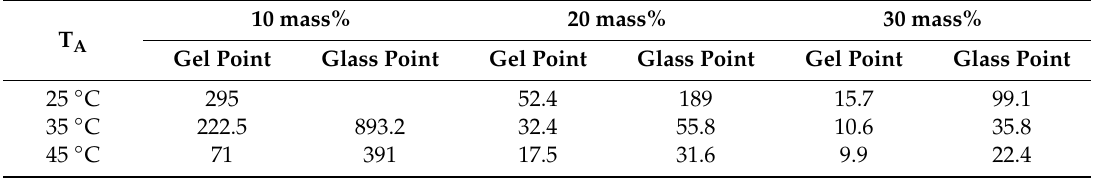
Table 3. Glass and gel points for the waterglass samples with added BPO 4 .